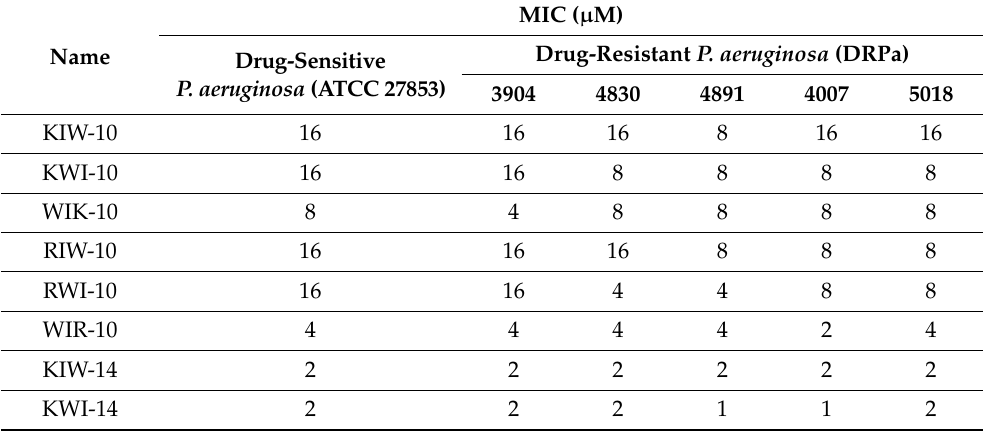
Table 1. Growth inhibition of peptides against drug-sensitive and drug-resistant P. aeruginosa